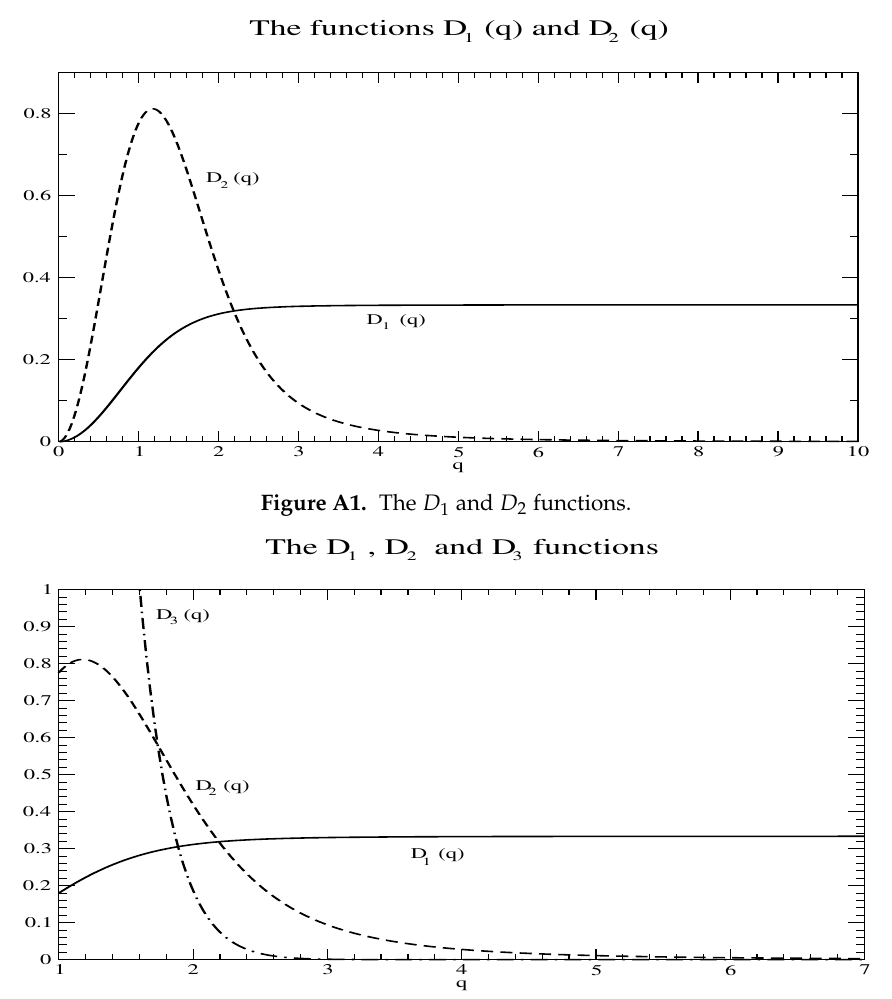
Figure A2. The D 1 , D 2 and D 3 functions for q >